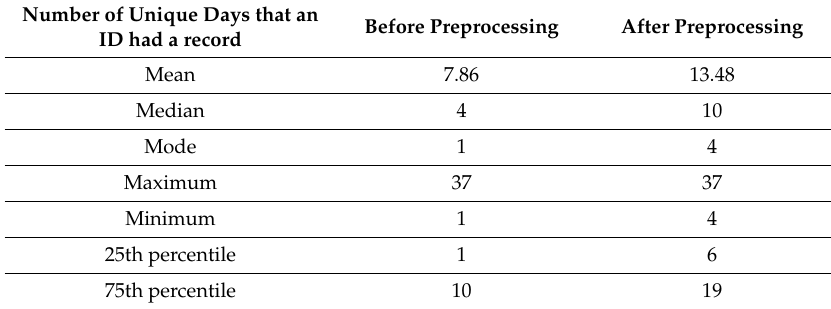
Table A1. Before preprocessing, the IDs had an average of 7.86 days with a record. Preprocessing eliminated many IDs with one or two records total, bringing the average days the IDs had a hit up to 13.48.